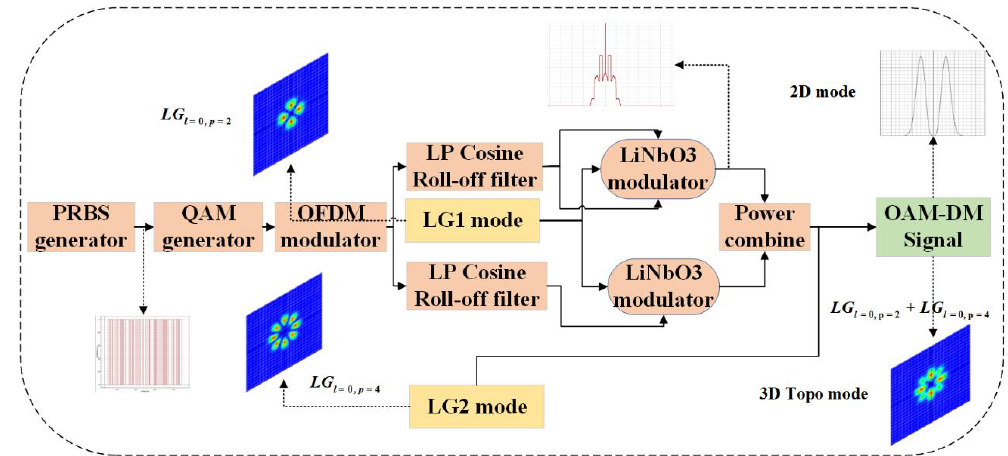
Figure 1. The schematic of the OAM-DM-WDM-OFDM-PON system transmitter.